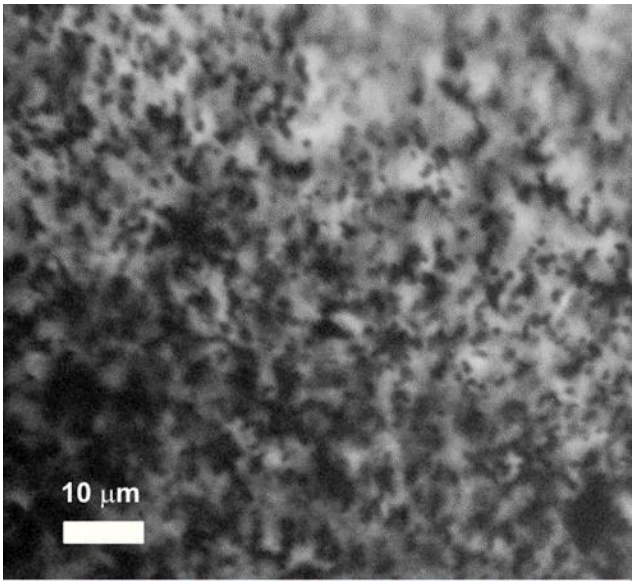
Figure 4. Optical microphotograph of FG with PAAm/Xanthan network and iron oxide content 1.9% (wt.). Image obtained by “ Micromed-I ” microscope (Micromed Ltd., St. Petersburg, Russia).